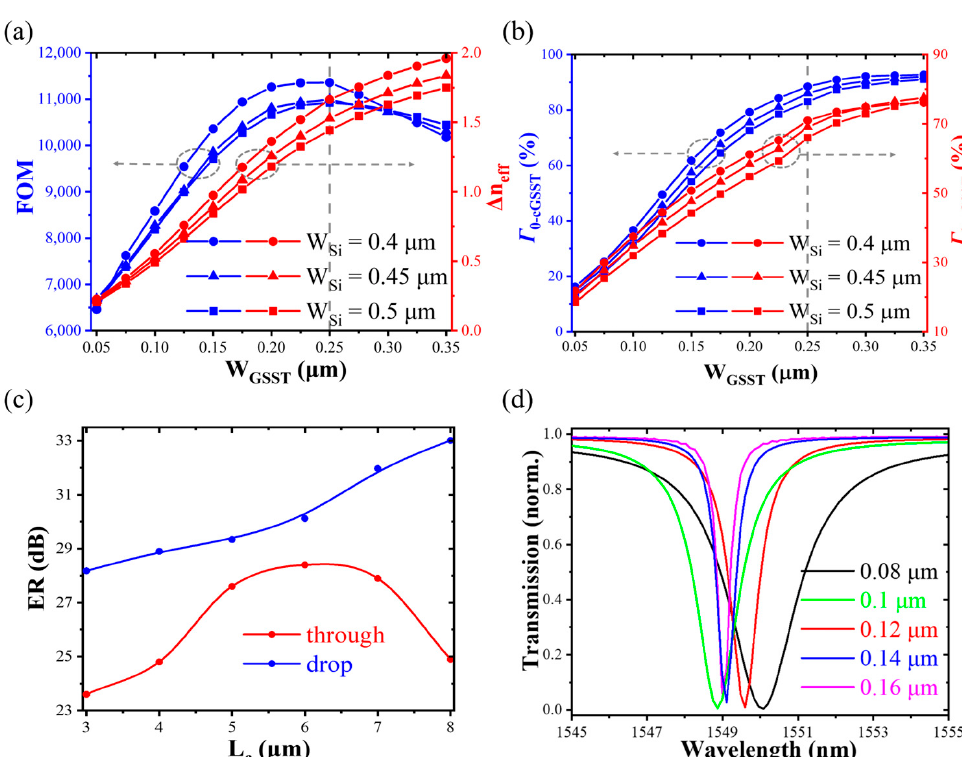
Figure 2. ( a ) Dependence of FOM and ∆ n eff on GSST-slot width. ( b ) Γ 0 versus GSST-slot width in the crystalline and amorphous states. ( c ) ER versus the coupling length. The relevant parameters of the device are set as W g = 0.15 µ m, W Si = 0.45 µ m, L GSST = 1 µ m, and W GSST = 0.25 µ m. ( d ) The coupling gap versus the transmittance of the device in the amorphous state.